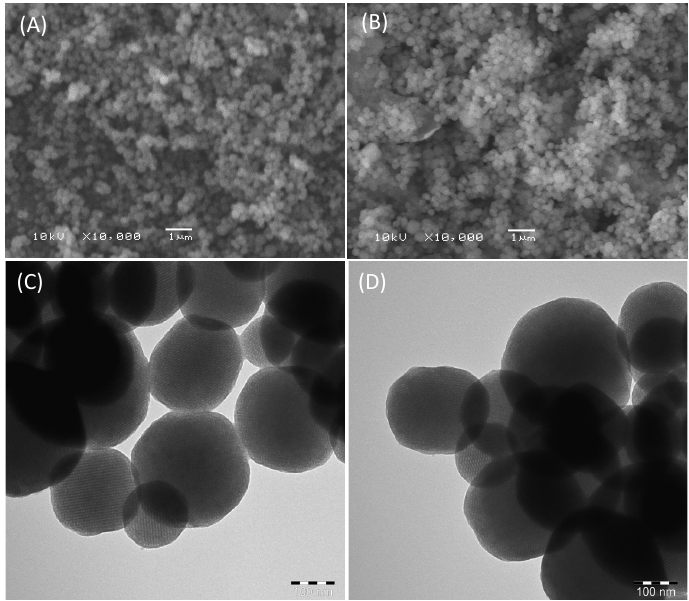
Figure 5. The SEM images of CTAB free MSNPs ( A ) and Ar ‐ MSNPs ( B ), respectively. The TEM images of CTAB free MSNPs ( C ) and Ar ‐ MSNPs ( D ), respectively.